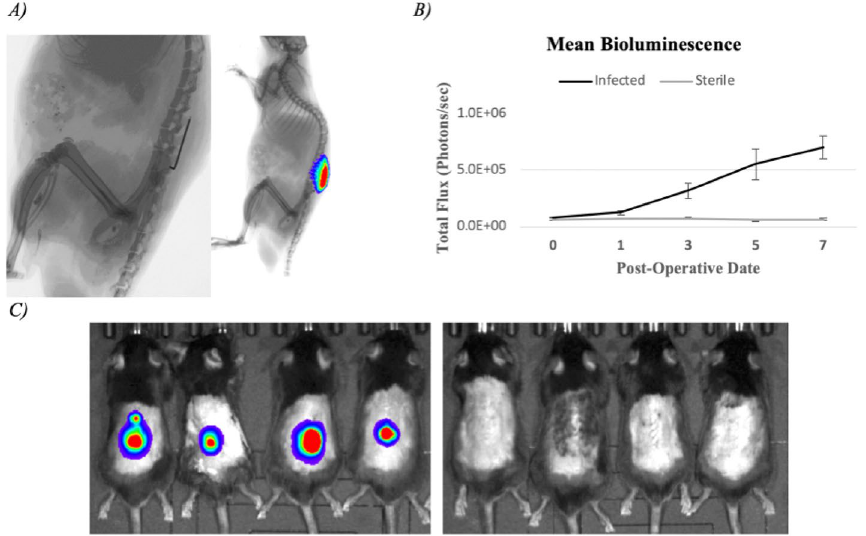
Figure 2. Spinal implant infection model. ( A ) Post-operative day 7 (POD 7) lateral XR revealing the position of the pin fixed within the spinous process in the lumbar spine and overlying bioluminescent signal of S. aureus Xen36. ( B ) Mean total bioluminescence represented as total flux (photons/sec) at each POD with error bars derived from Standard Error of the Mean for the Infected (n = 10) and Sterile (n = 5) cohorts. ( C ) Representative bioluminescence images of four mice from the Infected and Sterile Cohorts at post-operative day